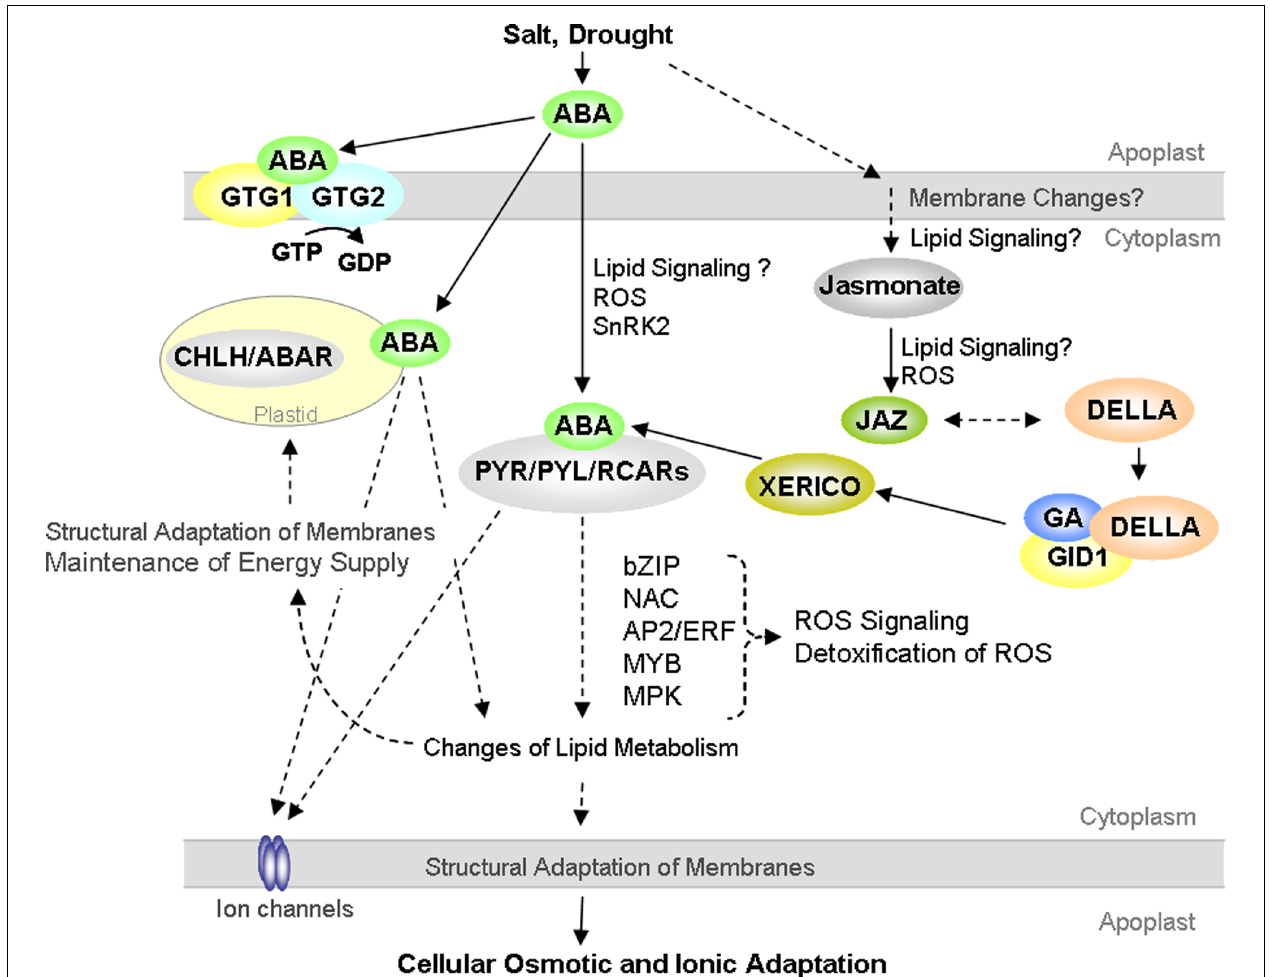
FIGURE 1 | Proposed model on crosstalk of abscisic acid (ABA), gibberellic acid (GA), and jasmonate signaling in plant cellular responses to the abiotic stressors drought and salt. Hypothesized links are illustrated with dashed lines.The lines and arrows illustrate pathways that are not shown and described in detail. Compare text for